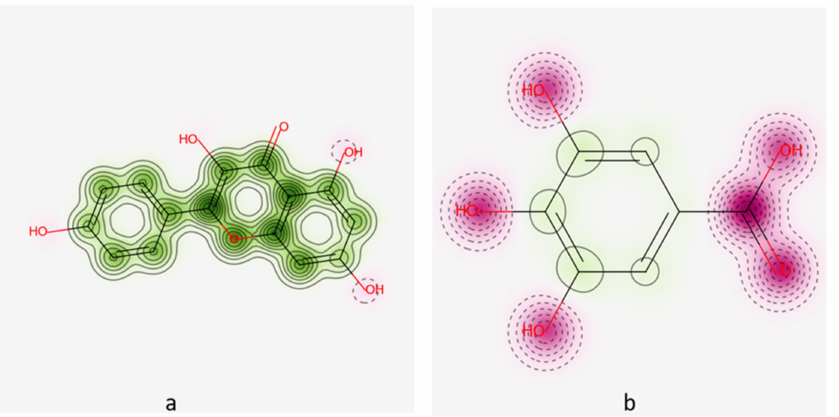
Figure 3. Cardiotoxicity analysis via Pred-hERG software ( a ) Kaempferol ( b ) Gallic